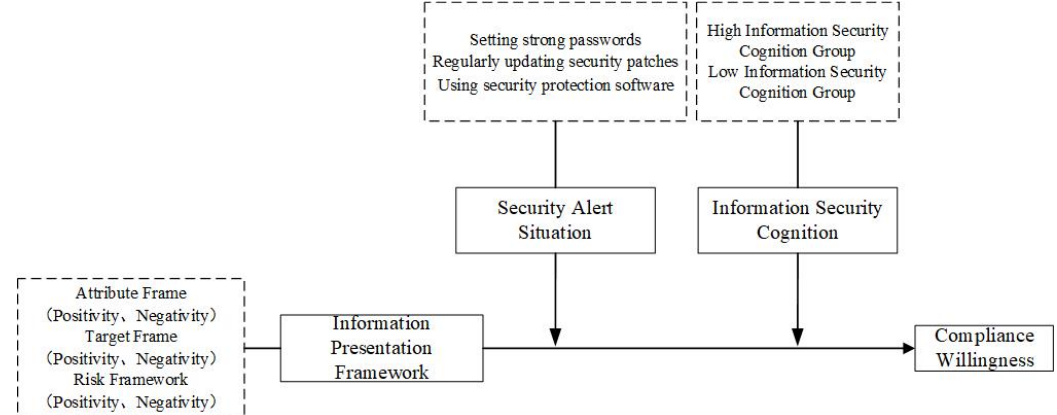
Figure 2. Theoretical Analysis Framework.